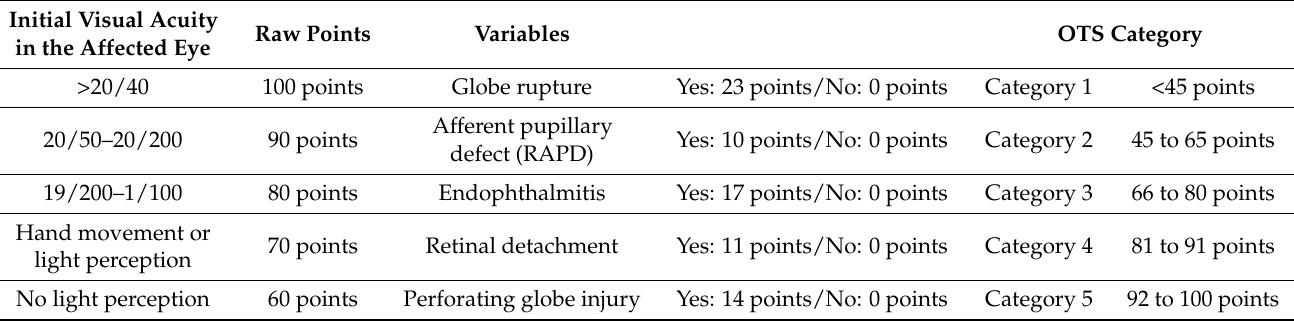
Table 1. Calculating the Ocular Trauma Score